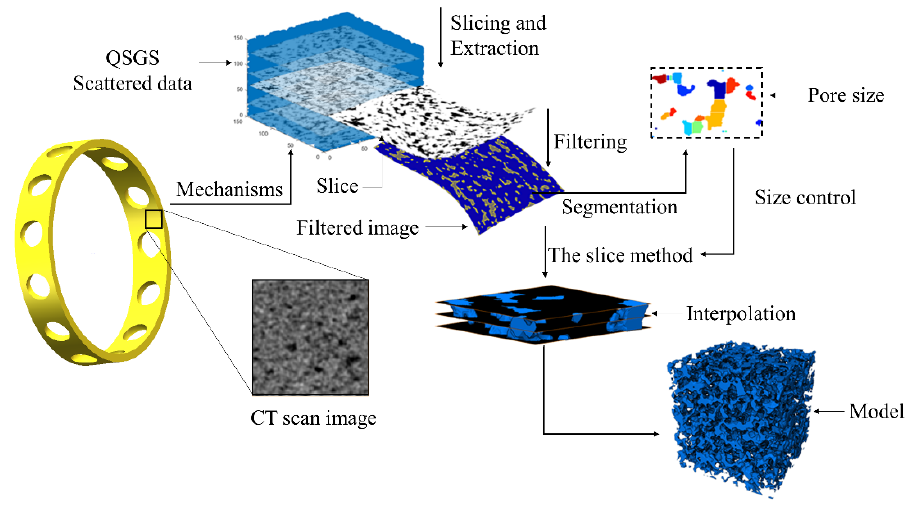
Figure 1. Modeling idea.